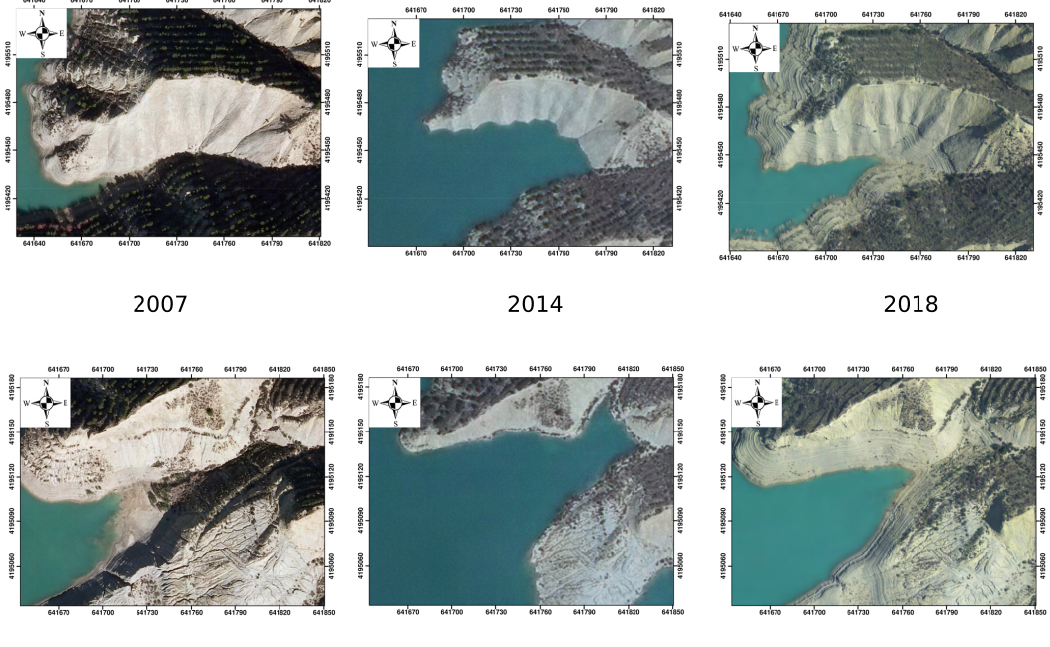
Figure 18. Temporal disappearance of the small bank gullies.